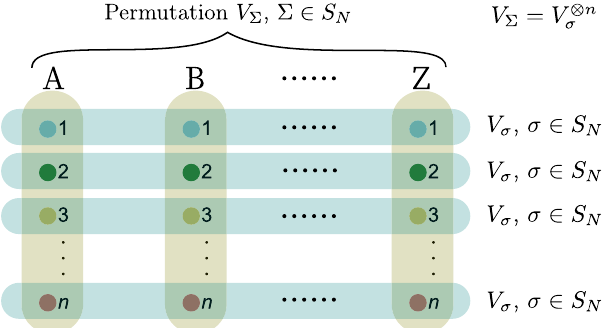
Fig. 2 Complete hierarchy for the marginal problem. In order to formulate the hierarchy for the marginal problem, one extends the two copies in Fig. 1 to an arbitrary number of copies N . If the marginal problem has a solution (cid:2) (cid:3) (cid:2) φ , then there are multi-party extensions Φ AB ⋯ Z in the symmetric subspace speci fi ed by V Σ ¼ V (cid:2) n σ for any number of copies, obeying some semide fi nite